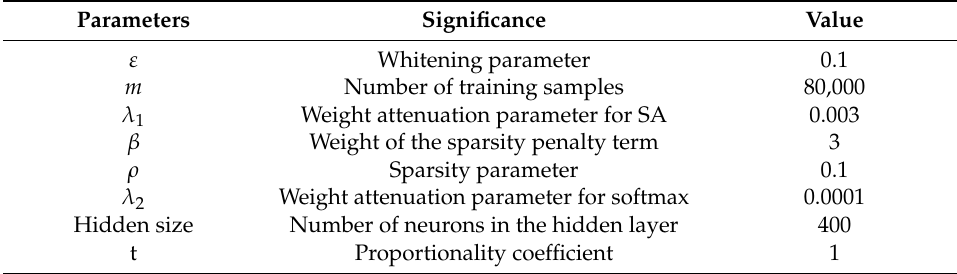
Table 5. The parameters of the whole system.